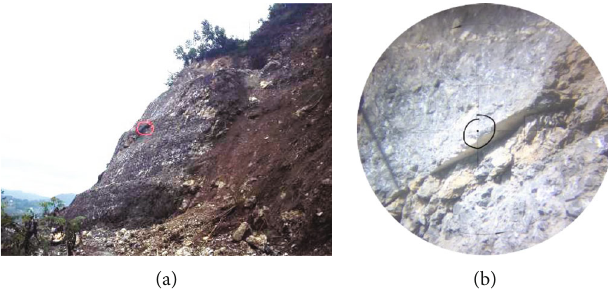
Figure 6: Drawing and operation drawing of slide monitoring point.